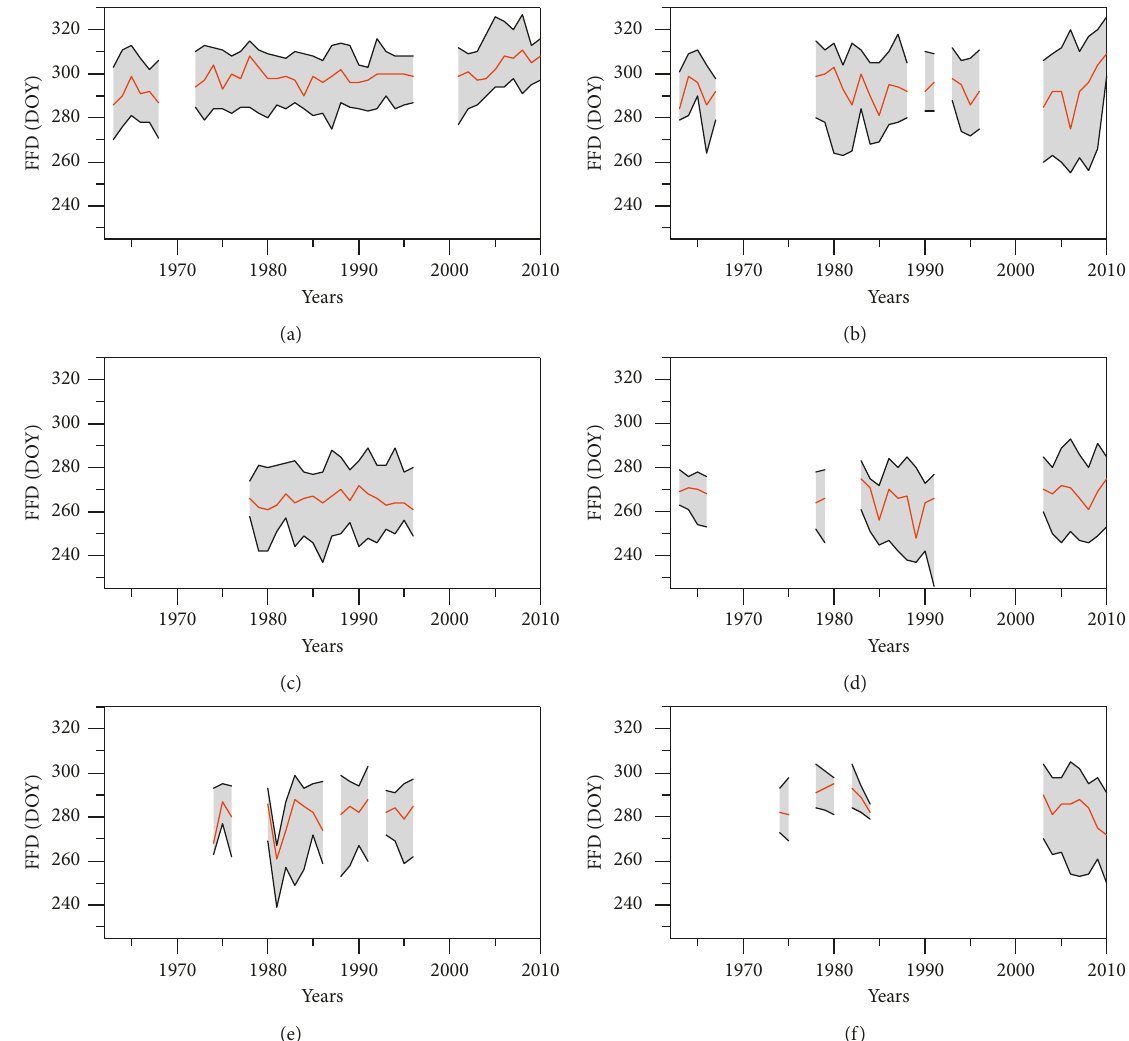
Figure 5: Interannual variations of the start, peak, end, and duration of the leaf coloring season (LCS) at six sites. The red line shows the peak of the LCS. The shadow area is the duration of the LCS. The upper and lower edges of the shadow area represent the start and end of the LCS, respectively. (a) Beijing. (b) Xi’an. (c) Mudanjing. (d) Harbin. (e) Minqin. (f) Shenyang.